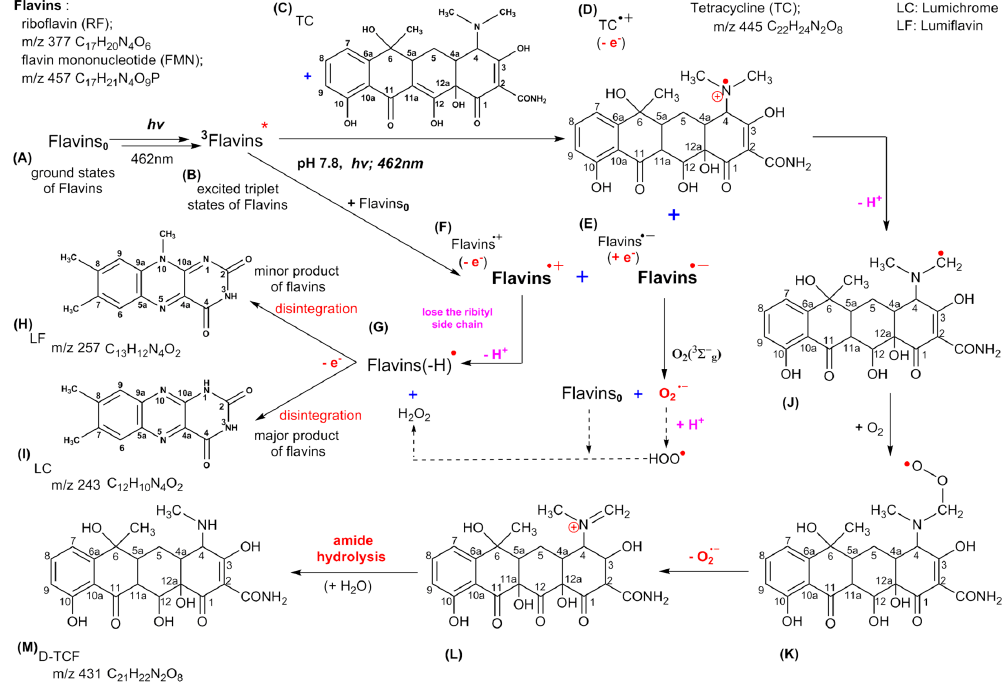
Figure 10. Proposed scheme for the photodegradation mechanisms of FMN/TC, where ( A ) is ground state of flavins; flavins 0 , ( B ) is excited triplet states of flavins; 3 flavins*, ( C ) is tetracycline (TC), ( D ) is state of flavins; flavins 3 flavins*, ( C ) is tetracycline (TC), ( D ) 0 , ( B ) is excited triplet states of flavins;